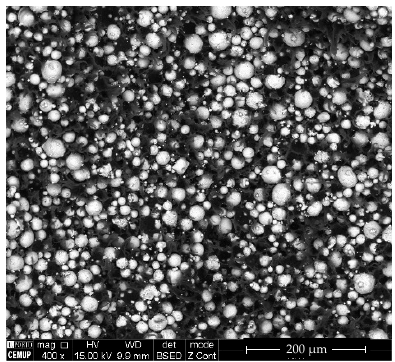
Figure 7. Micrography (SEM) of the green part.